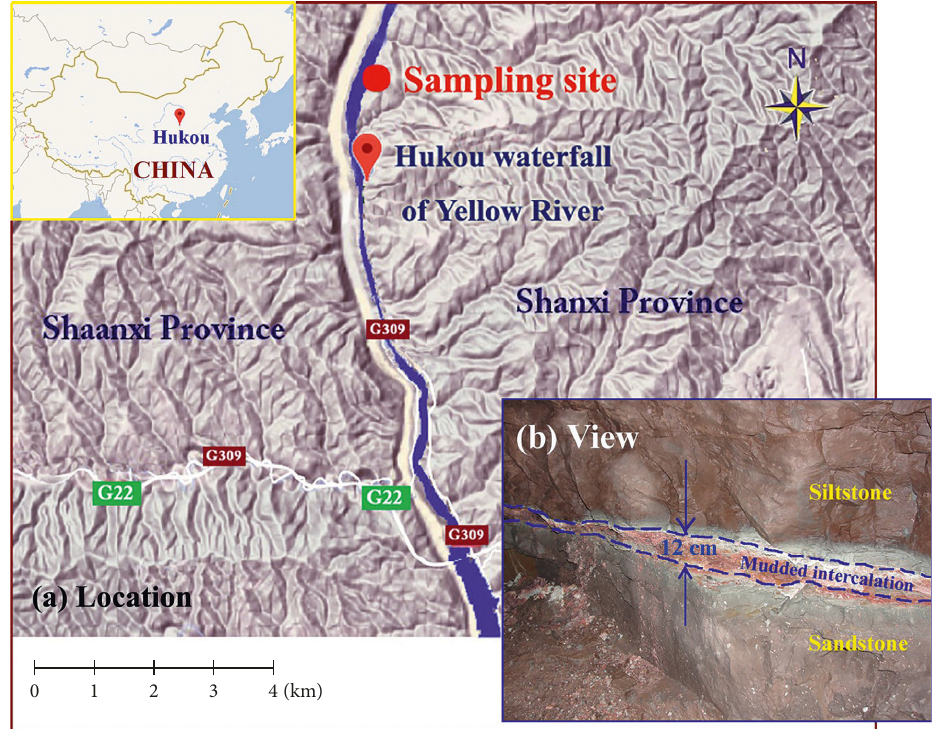
Figure 2: Specimen sampling sites: (a) location; (b)